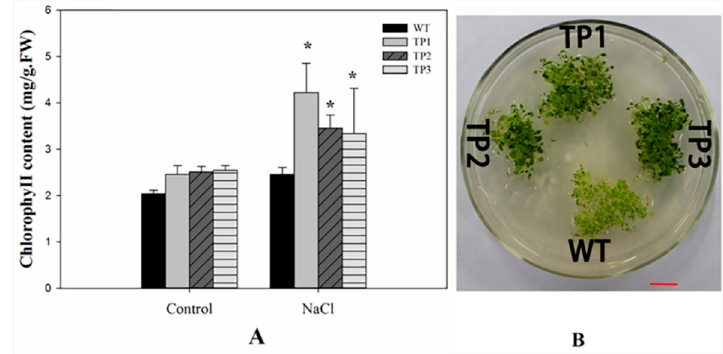
Figure 4. Chlorophyll content of WT and TPs under salt stress treatment. ( A ) Chlorophyll content of 3-week-old wild-type plants and transgenic lines under 150 mM NaCl treatment. All experiments were repeated at least three times. Error bars indicate the standard deviation (SD). * and ** indicate that the values for the transgenic plants were significantly different from those of the wild type under the same conditions with P < 0.05 and P < 0.01. ( B ) The transgenic plants had larger and greener cotyledons than the wild-type lines under the 150 mM NaCl treatment. The scale bar represents 1 cm.